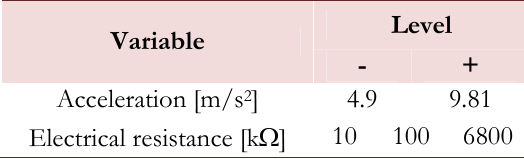
Table 2: Variables of the full factorial experimental plan.